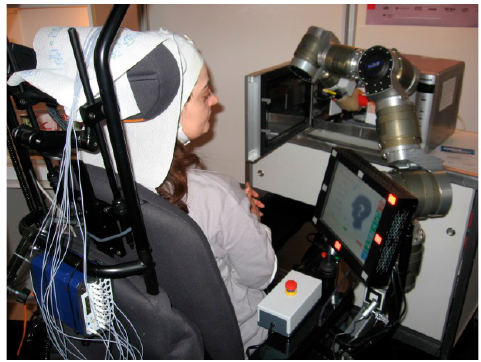
Figure 1. Control of FRIEND with a SSVEP-BCI in an ADL-test bed. SSVEP Diodes are located at the frame of the